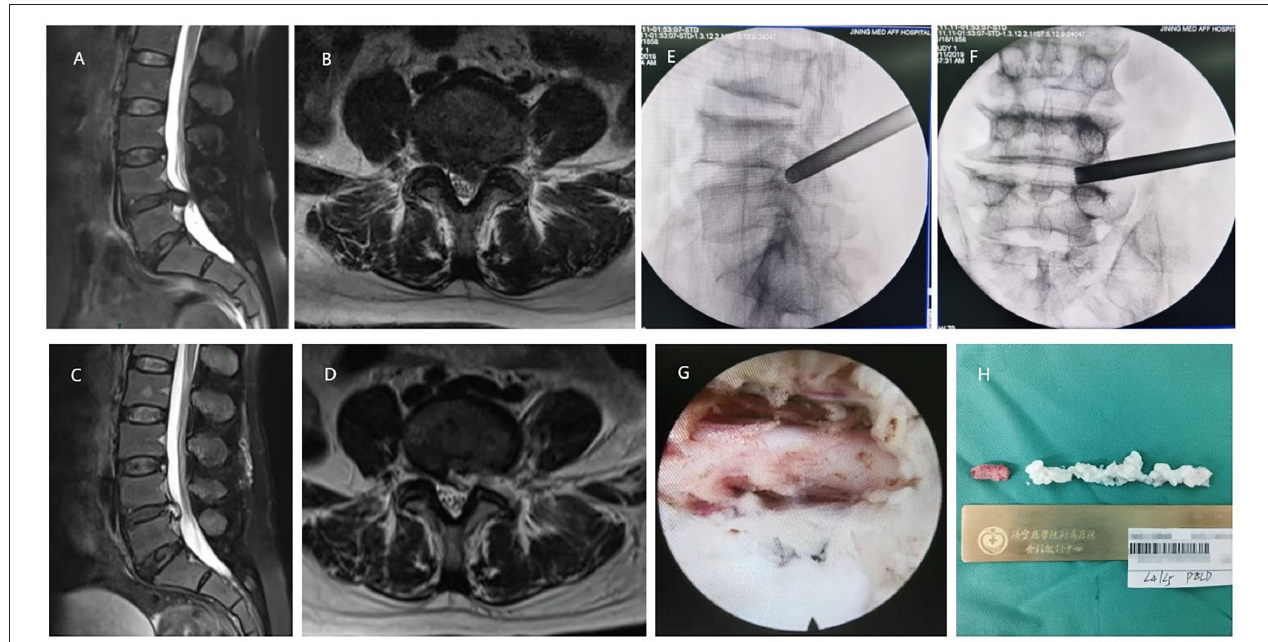
FIGURE 1 | A 67-year-old female with the L4/5 lumbar intervertebral disc herniation (LDH) underwent percutaneous endoscopic lumbar discectomy (PELD) with the approach of transforaminal. (A,B) Preoperative MRI showed LDH was located at the L4/5 level. (C,D) Postoperative MRI revealed the herniated nucleus pulposus tissues were removed and the nerve root was decompressed. (E) Intraoperative C-arm fluoroscopy showed the location of the working channel on lateral film. (F) Intraoperative C-arm fluoroscopy showed the location of the working channel on anteroposterior film. (G) The decompressed nerve root under endoscopic view. (H) Resected nucleus pulposus tissues in the operation.